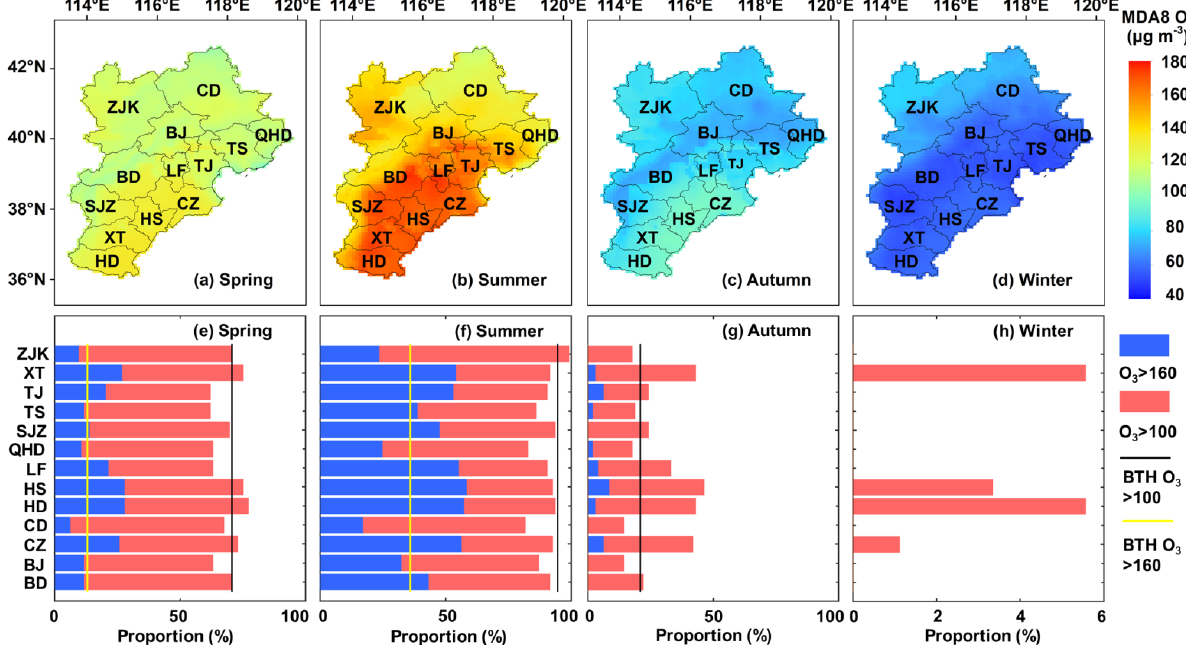
Figure 5. Spatial distributions of the seasonal MDA8 O 3 concentration ( a – d ) and proportion of O 3 pollution time in 13 cities across the BTH region in 2018: ( a , e ) Spring; ( b , f ) summer; ( c , g ) autumn; and ( d , h ) winter.